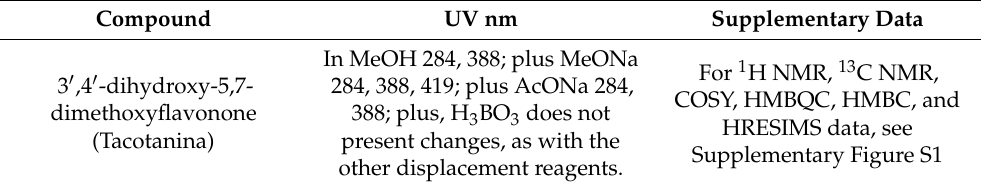
Table 2. UV nm spectral data for the Flavanone